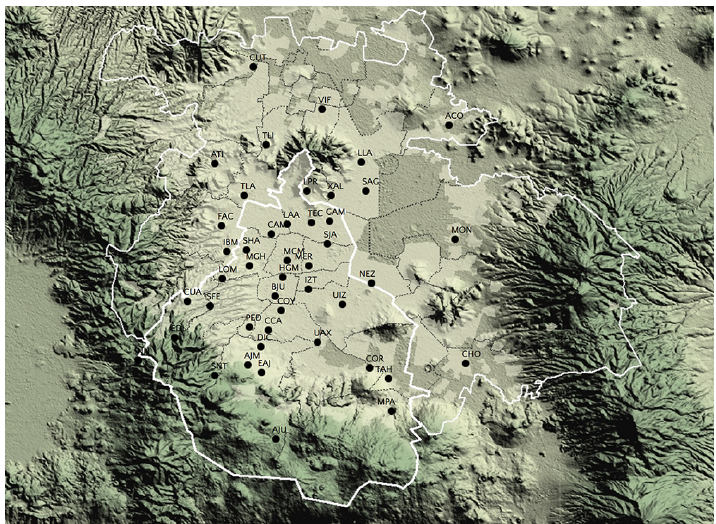
Figure 2. Locations of monitoring sites in the